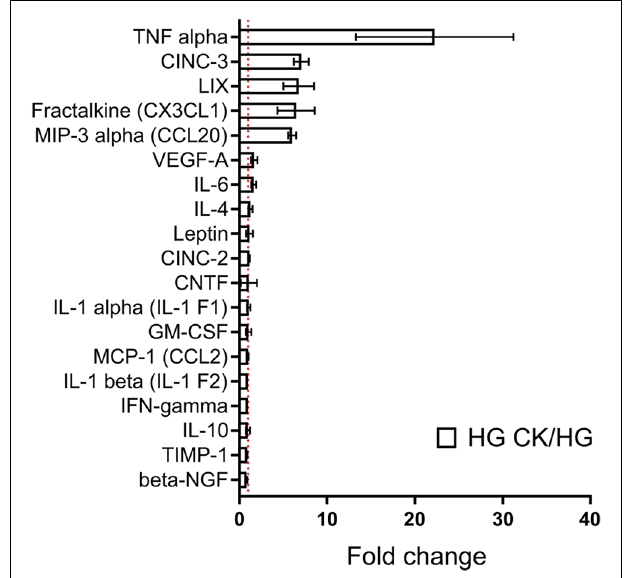
FIGURE 2 | Effect of HG on cytokine and chemokine release profile in CK-activated rMC-1 cells. Bar plot represents cytokines and chemokines profile of rMC-1 cells exposed to HG and eventually treated with the CK mix (HG CK); the results are shown as values obtained from HG CK condition normalized over HG. Fold values are expressed as mean ± SEM of three independent